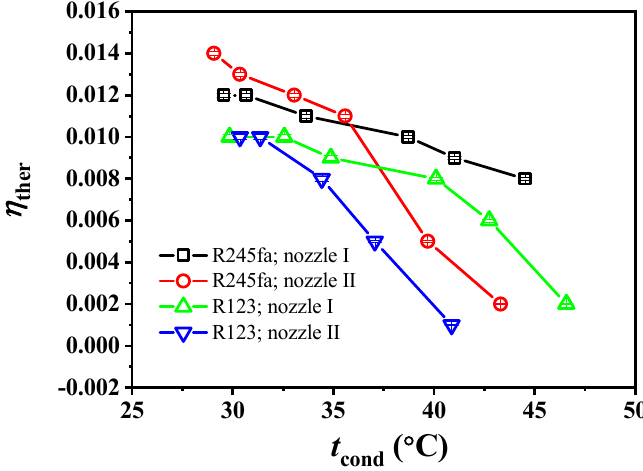
Figure 11. Variation of specific energy with condensing temperature.